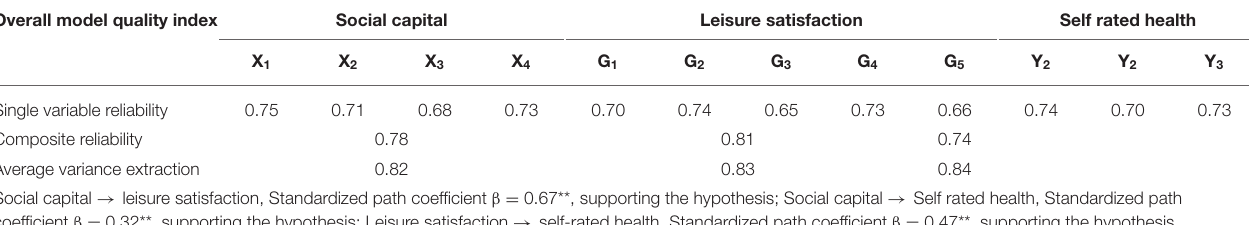
TABLE 5 | Parameter estimation and internal quality inspection statistics of the structural model validation analysis.